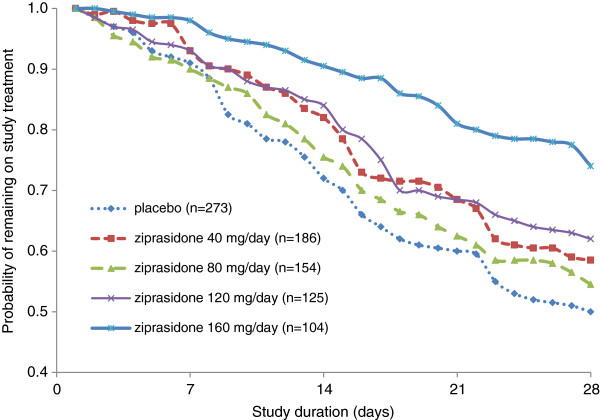
All-cause discontinuation survival curves by ziprasidone dose. Reproduced with permission
[185].